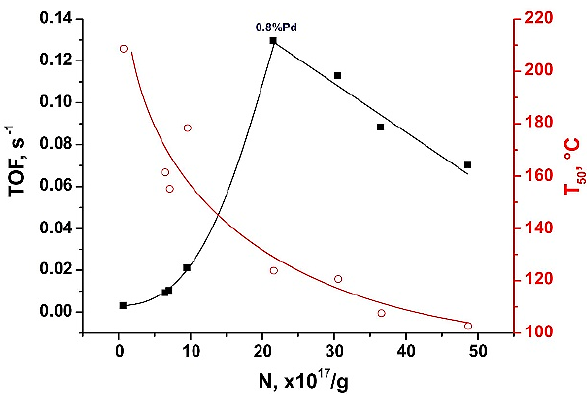
Figure 15. Catalytic performance of Pd/ZrO 2 samples in the CO oxidation (turnover frequency and T 50 ) vs. concentration of TNB − radicals detected on their surface. TOF was calculated for temperature of 150 °C.